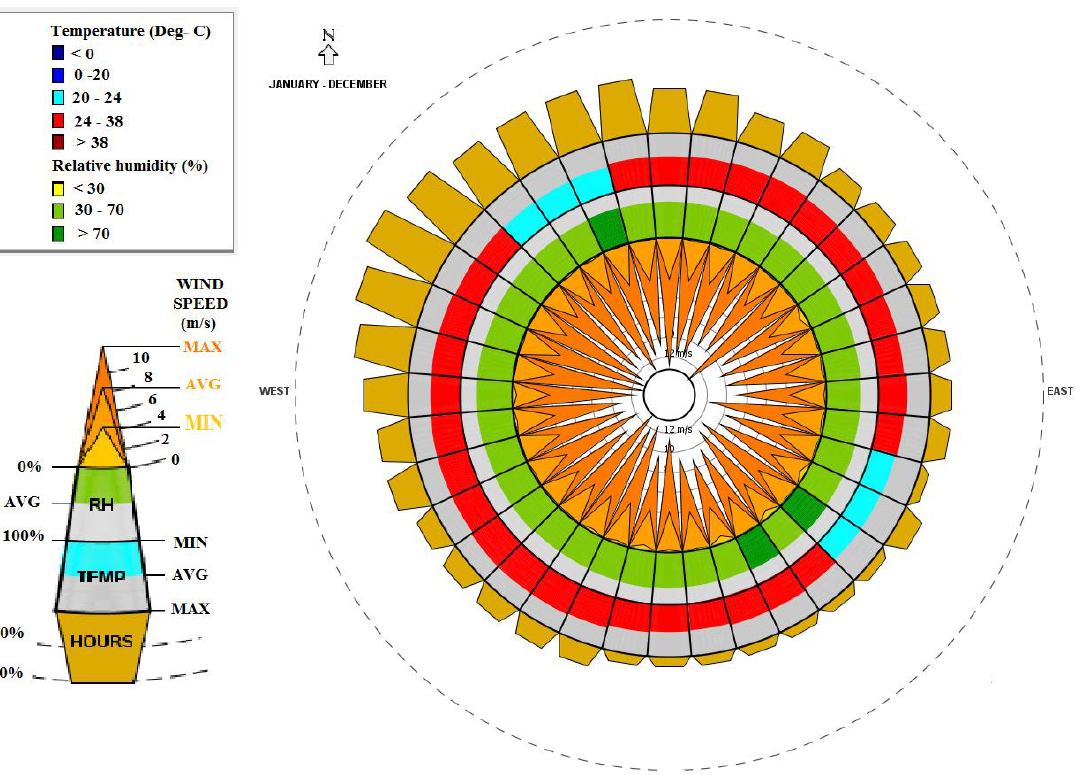
Figure 3. Daily average of wind velocity variation and direction during a year at Bushehr (Climate Consultant